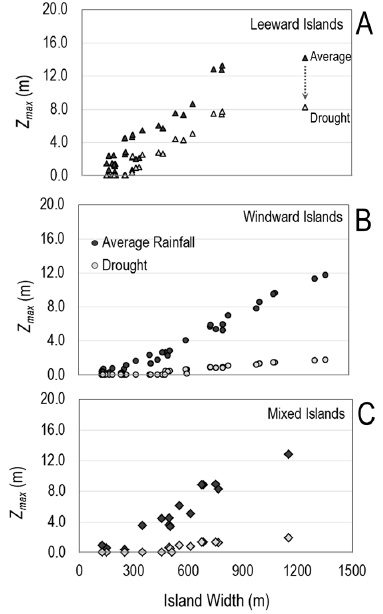
Figure 9. Z max (m) during average rainfall conditions (dark data points) and severe drought conditions (light data points) for islands positioned on the ( A ) leeward; ( B ) windward; and ( C ) mixed sides of an atoll, plotted against island width. The depletion is most severe for windward islands ( B ) and mixed islands ( C ). In ( A ), the decrease from average to drought conditions for an island is shown with a dotted gray arrow.